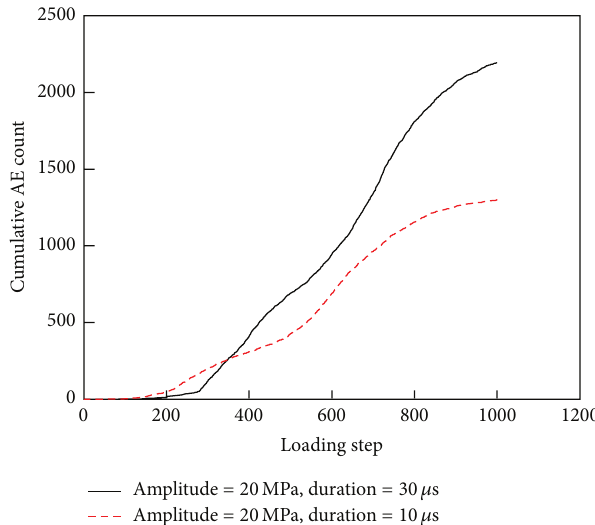
Figure 11: Variation of accumulated counts of failed elements (AE) of sample under different stress wavelength.